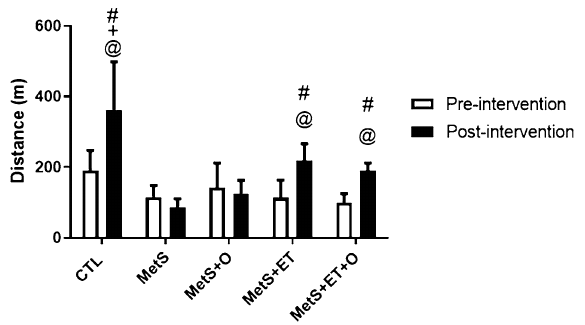
Figure 1. Exercise capacity represented by maximal distance run. CTL–Control, MetS–Metobolics Syndrome, MetS+O–Metabolic Syndrome and Okra, MetS+ET–Metabolic Syndrome and Exercise Training, MetS+ET+O– Metabolic Syndrome and Exercise Training and Okra. @ In the same group, #Diffrent from MetS post- intervention, +Different from MetS+O post-intervation. p ≤